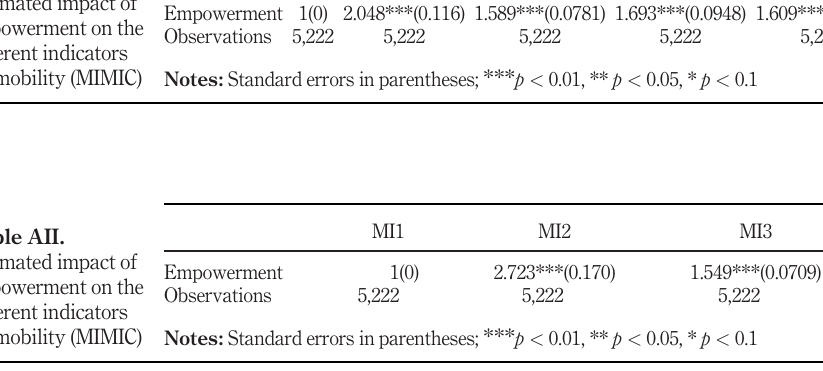
Table AI. Estimated impact of empowerment on the different indicators for mobility (MIMIC)